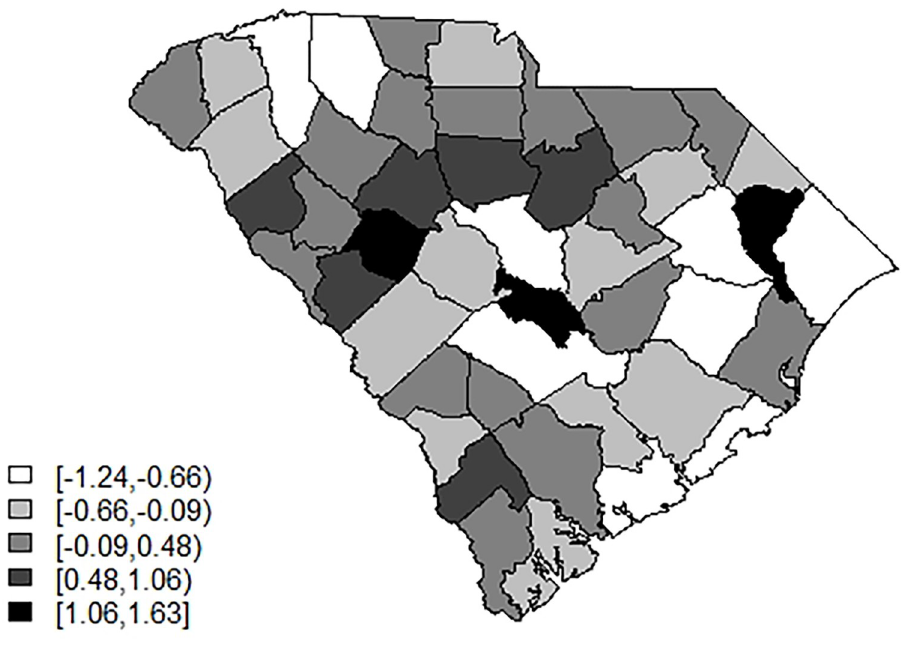
Fig 6. Posterior mean uncorrelated random effect for model